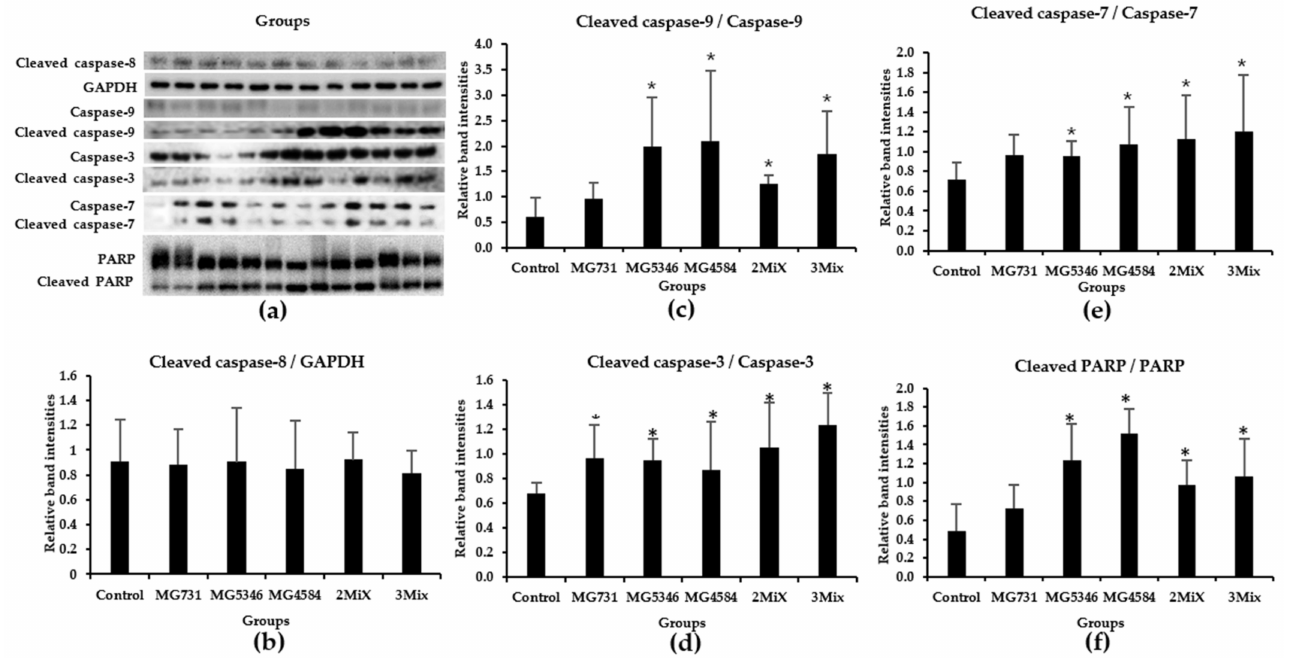
Figure 4. Protein levels in tumor tissues. After 19 days of treatment with heat-killed single strains